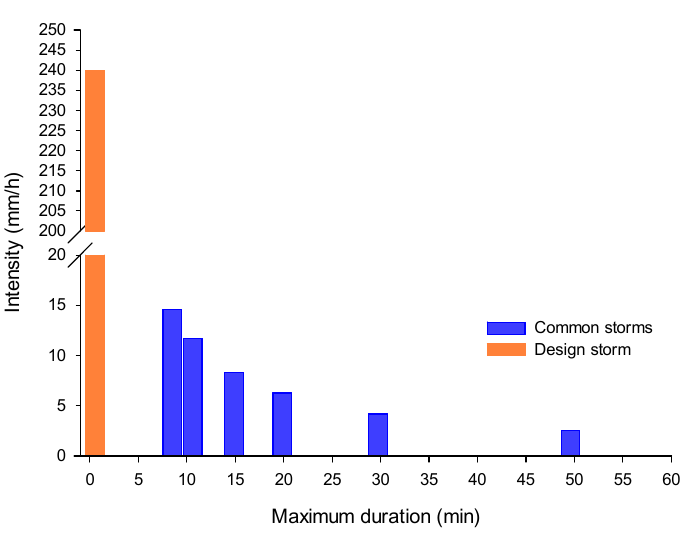
Figure 8. Rainfall events for which the infiltration trench is efficient.